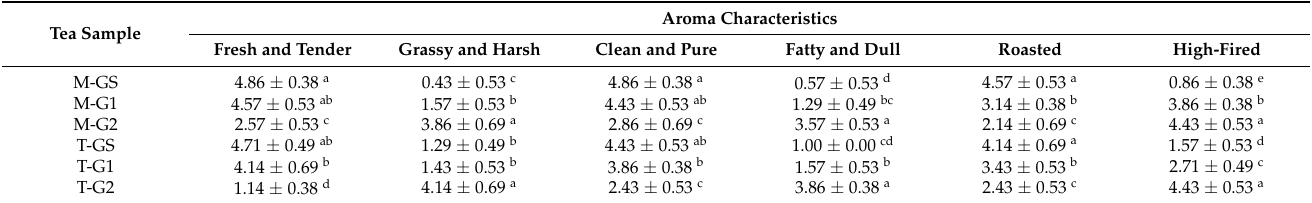
Table 1. Aroma characteristics and intensity description of Shandong matcha and tencha. Aroma Characteristics Clean and Pure Fatty and Dull Roasted